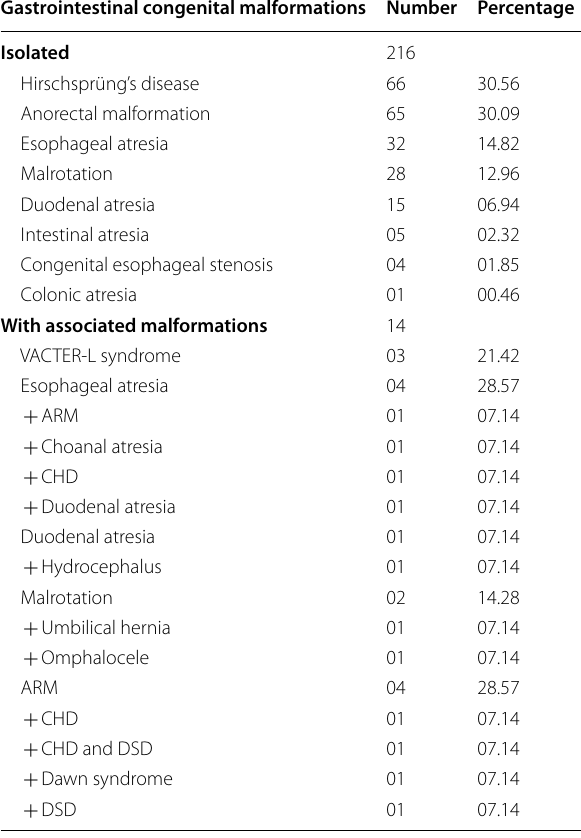
ARM Anorectal malformation, CHD Congenital heart disease, DSD Disorder of sexual development, GIT Gastrointestinal tract, VACTER-L Vertebral, anorectal, cardiac, tracheoesophageal, renal, limbs malformations Table 3 Mortality and lethality of malformations